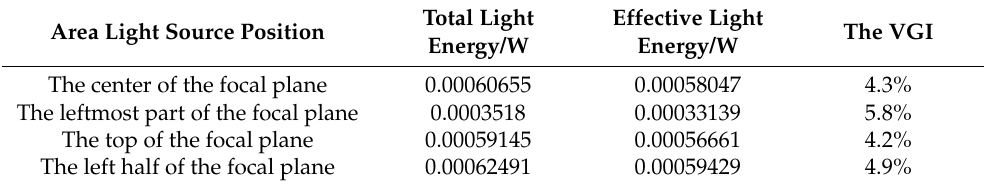
Table 7. Simulation results of the VGI at different small surface light sources.